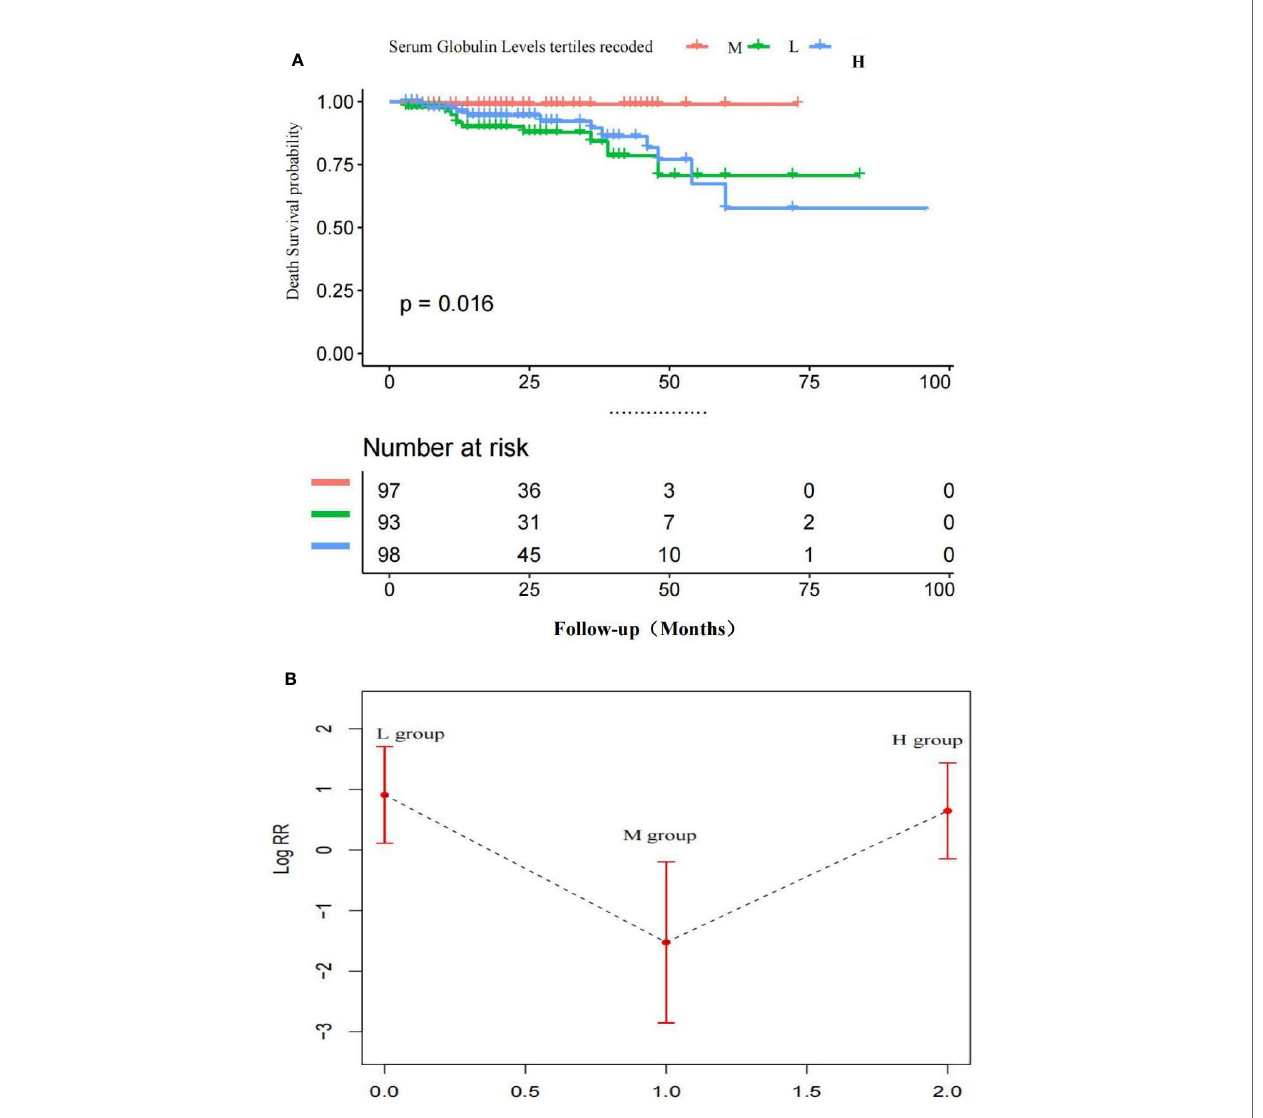
FIGURE 3 | (A) Adjusted Kaplan-Meier curves of all-cause death outcome according to serum globulin levels *Survival in the M group was signi fi cantly higher than the H group and L group. (B) Adjusted Log risk ratios (RRs) for all-cause death outcome by tertiles of serum globulin levels. A U-shaped association was shown to exist between the serum globulin level and all-cause deaths in patients with MM. P < 0.05 M vs. H group; P < 0.05 M vs. L group; P > 0.01 H vs. L